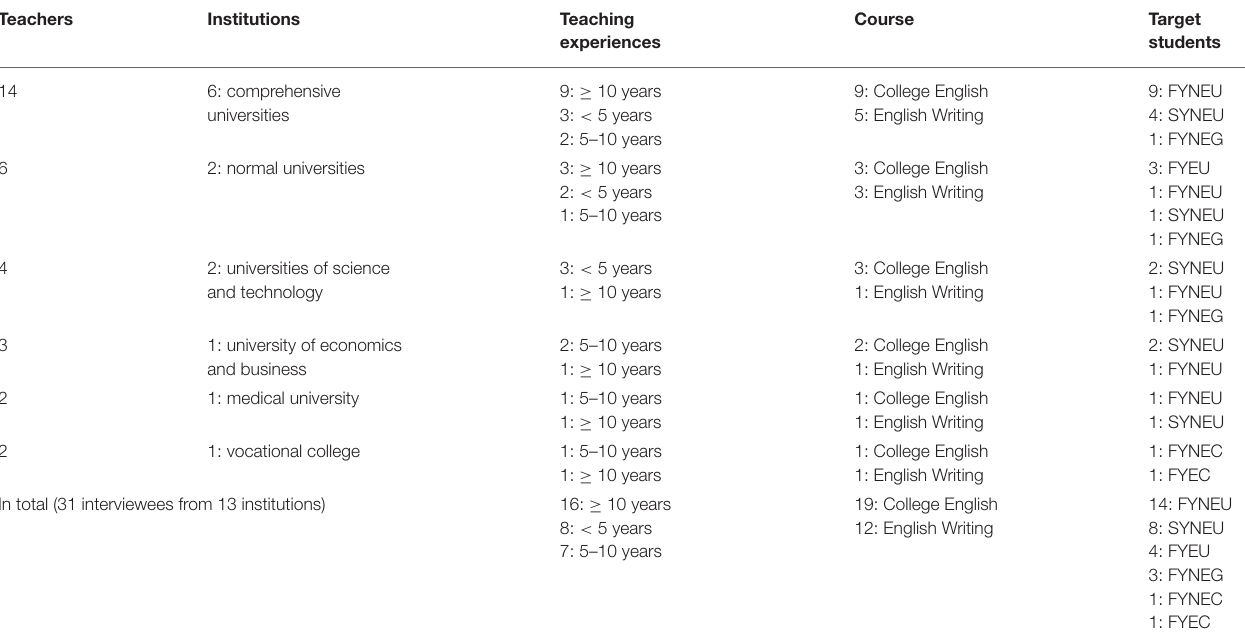
TABLE 1 | Interviewees’ demographic